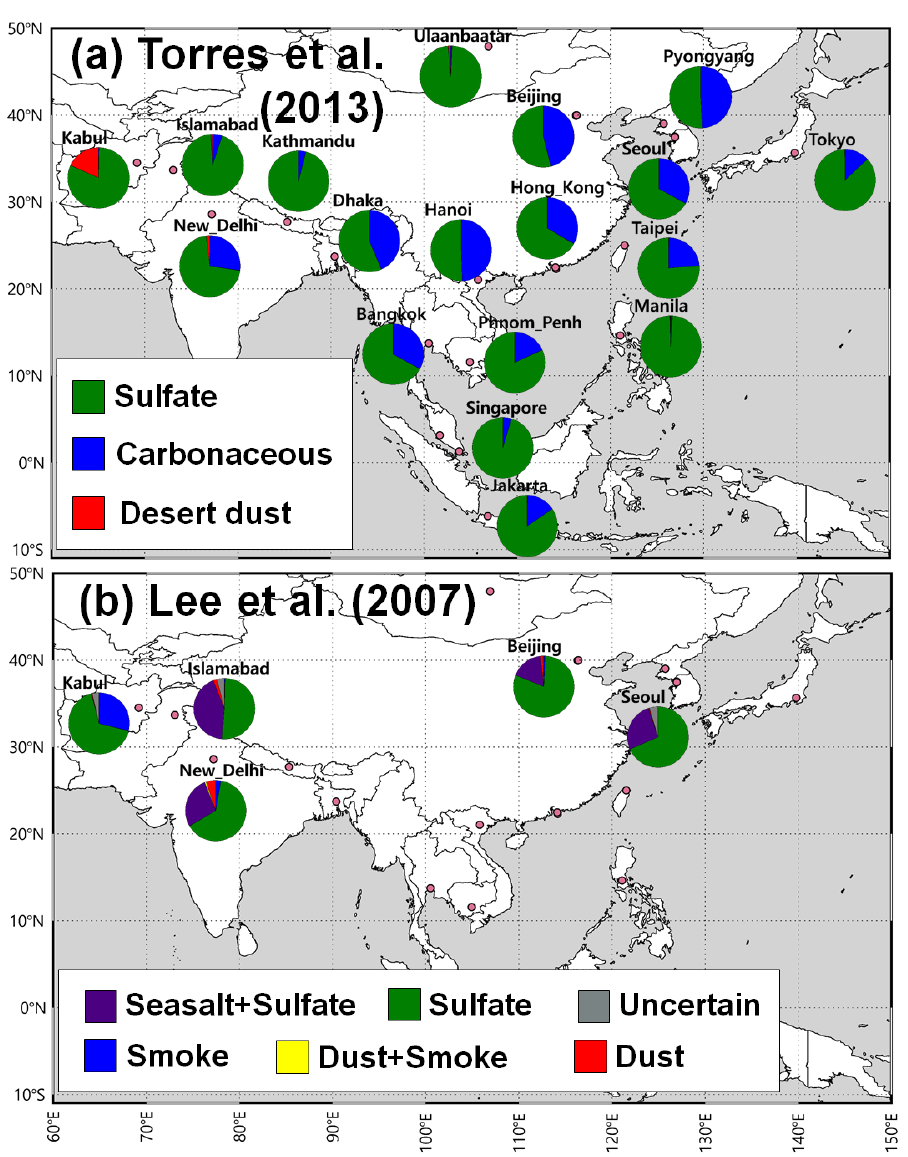
Figure 4. Distributions of aerosol types detected by ( a ) Torres et al. [27] and ( b ) Lee et al. [26] in capital cities of Asia. Abbreviations: NA, non-absorbing; SA, strongly absorbing; DDM, dust dominated mixed; PD, pure dust.